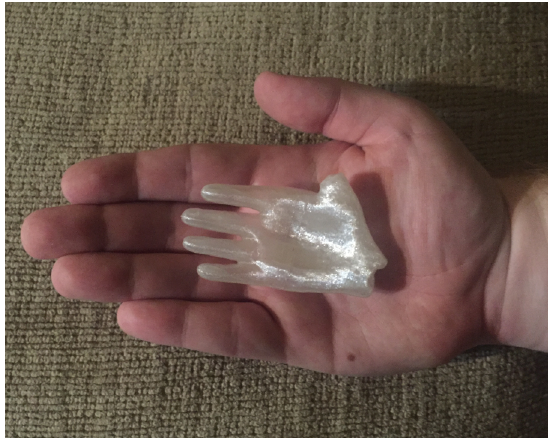
Figure 10: 3D print of a clay anatomical model of a hand (held in the